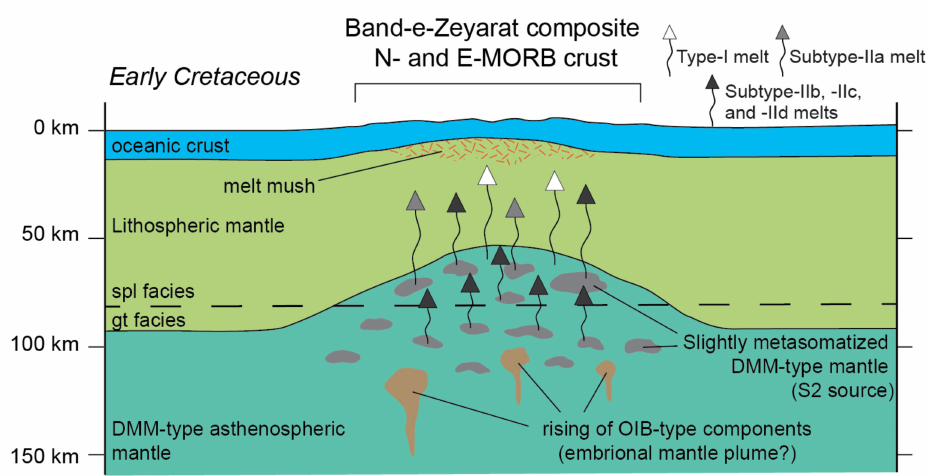
Figure 17. Conceptual two-dimensional cartoon showing the petrogenetic processes responsible for the formation of the N- and E-MORB composite crust of the Band-e-Zeyarat ophiolite in a mid-oceanic ridge tectono-magmatic setting. Abbreviations: N-MORB: normal mid-oceanic ridge basalt; E-MORB: enriched mid-oceanic ridge basalt; OIB: oceanic island basalt; DMM: depleted MORB